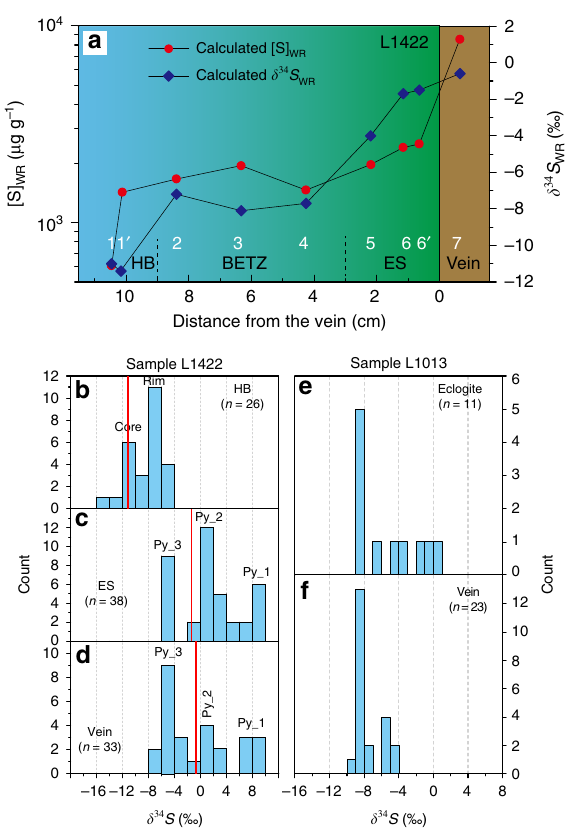
Fig. 5 Whole-rock (WR) and in situ pyrite δ 34 S compositions of vein samples. a Calculated [S] WR and δ 34 S WR compositions from bulk-rock analyses along the traverse of sample L1422. Errors of δ 34 S WR and S WR calculated from analytical reproducibility are smaller than the symbols used. HB host blueschist, BETZ blueschist – eclogite transition zone, ES eclogite selvage. b Histograms of in situ pyrite δ 34 S values in the HB, ES, and vein (sample L1422, red lines refer to the δ 34 S WR values). c Histograms of pyrite δ 34 S values in the sample L1013. Source data are provided in Supplementary Data. (<3 ‰ ) at different P – T conditions along the subduction interface (Fig. 7a – d). In particular, at the vein-forming P – T conditions of this study, f O 2 (<FMQ) 17 and pH range (pH n to pH n + 2) suggest sulfur isotope fractionations <1.3 ‰ (Fig. 7e). In addition, pre- cipitation styles of sul fi de in hydrothermal settings (closed- or open-system) may also in fl uence the sulfur isotope fractiona- tion 41 . In both closed and open systems, theoretical calculations (Method 3) display <1 ‰ fractionation if pyrite precipitated from H 2 S − dominated fl uids at 550 °C (Fig. 7f, g), consistent with previous calculations for subduction conditions 14,15 .